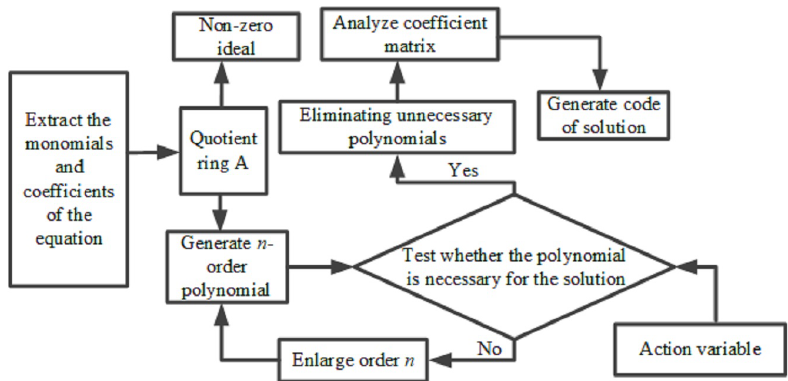
Figure 1. Schematic diagram of Gr¨obner generation